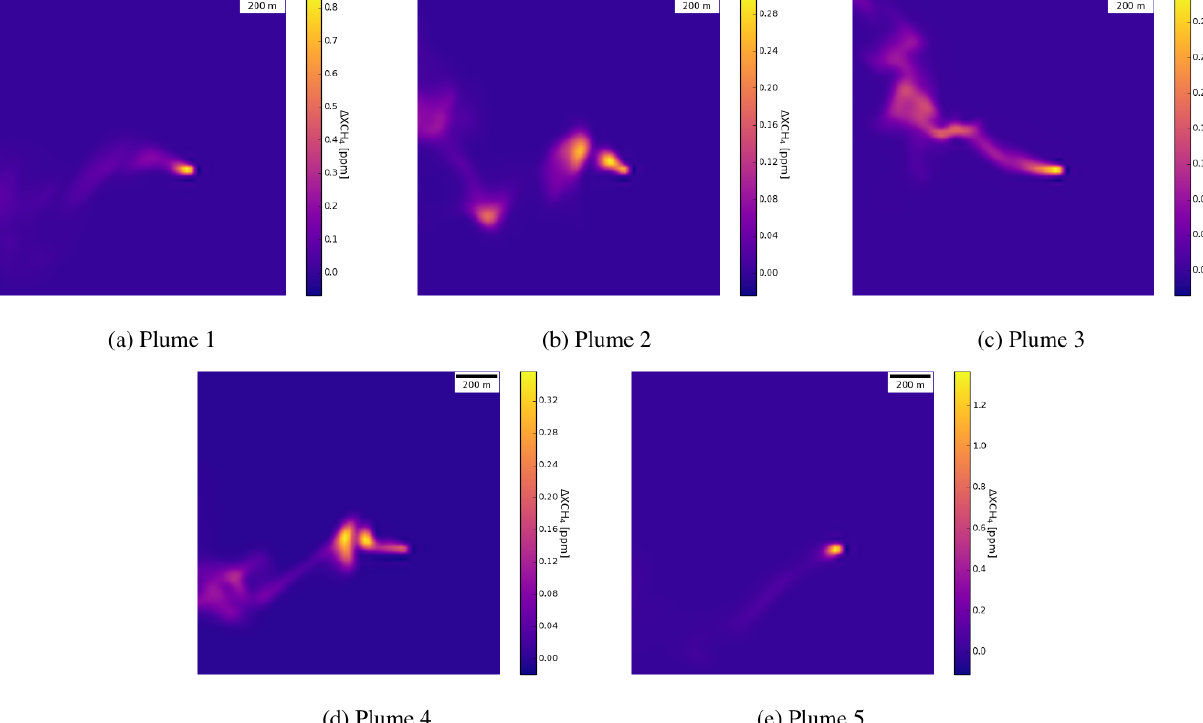
of the five plumes considered for the simulations scaled at a flux rate Q = 1000kgh − 1 after 4